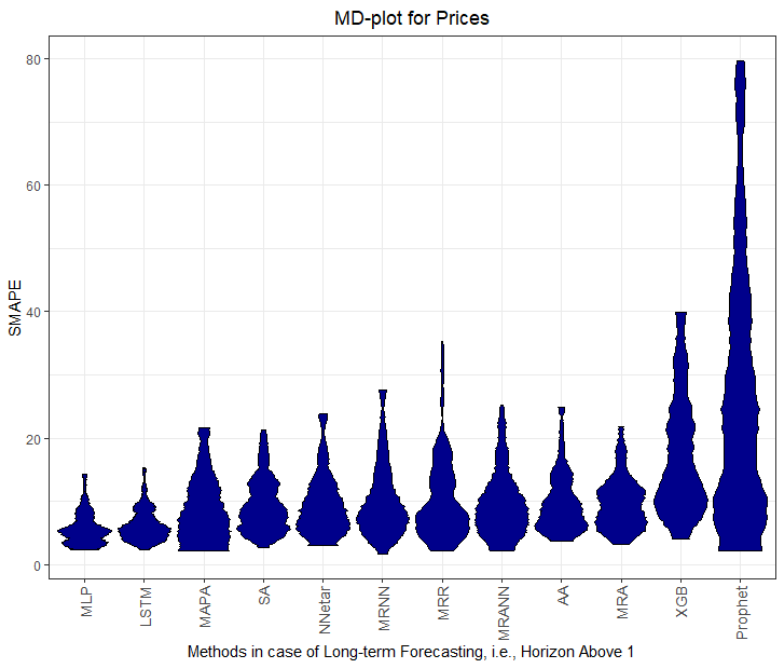
Figure A8. Mirrored density plot of Symmetric Mean Absolute Percentage Errors (SMAPE) computed with a rolling forecasting origin over all horizons on dataset Prices.